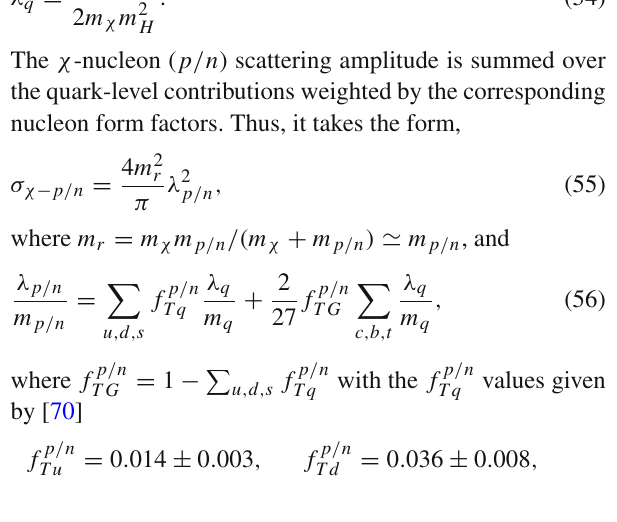
channel exchange of the Higgs H to